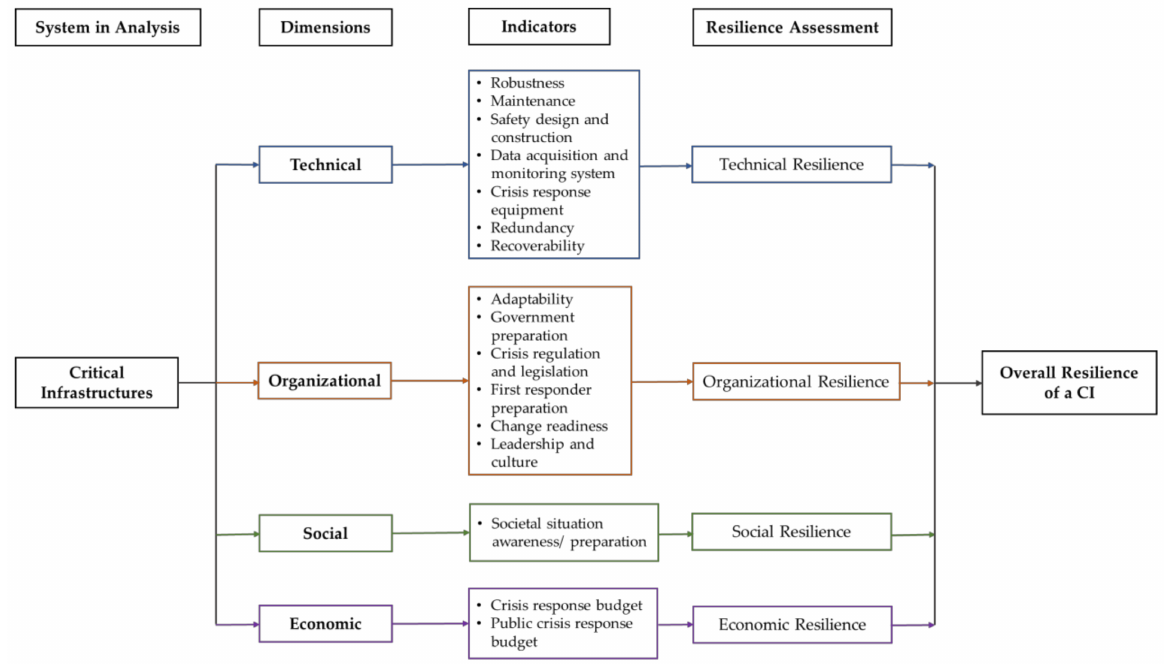
Figure 2. Typical framework for measuring CI